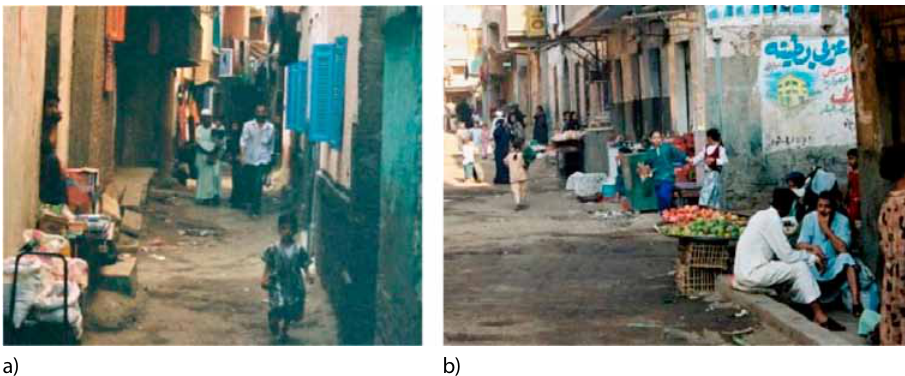
fig. 4 a, b: appropriation of urban spaces and fina’s in selling different goods where, as in photographs (a) and (b), shops owners lay out some goods in the front of their shops or, as in photograph (c) some vendors appropriate these places temporarily during the day